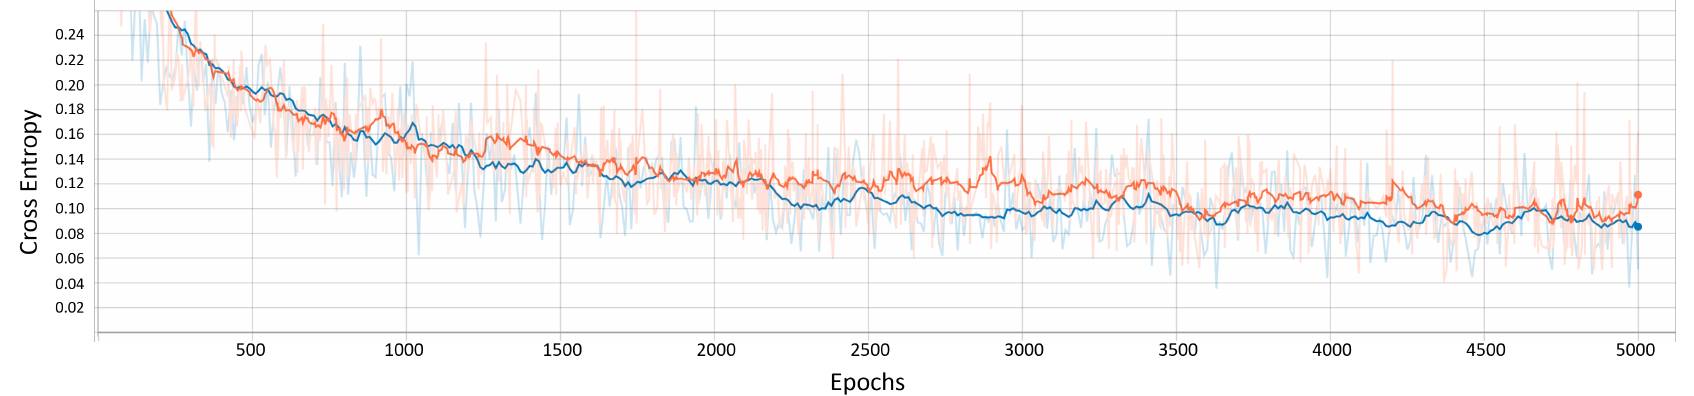
Figure 5. Graph of the accuracy obtained along the 5000 epochs, red line = train data, blue line = validation data.